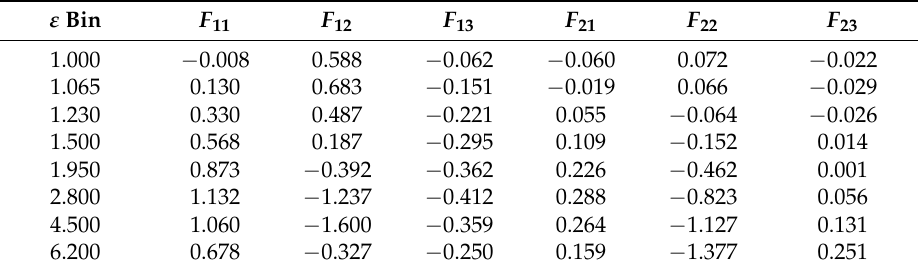
Table 5. Brightness coefficients for the Perez Anisotropic Sky